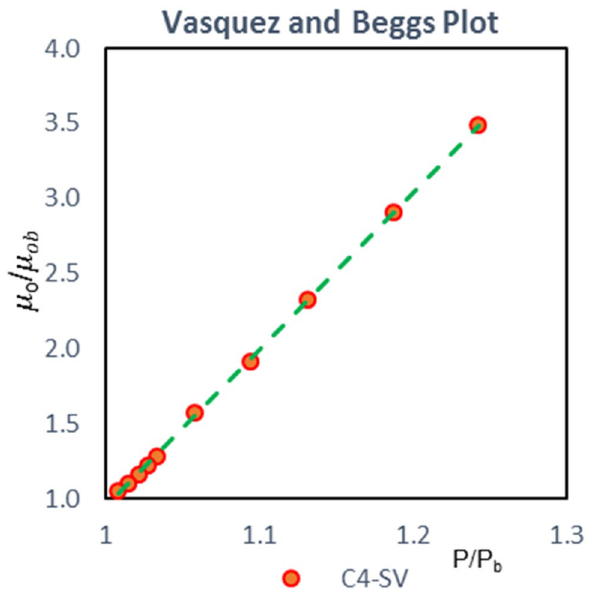
Fig. 10 Valid trend of oil viscosity from Vasquez and Beggs plot of